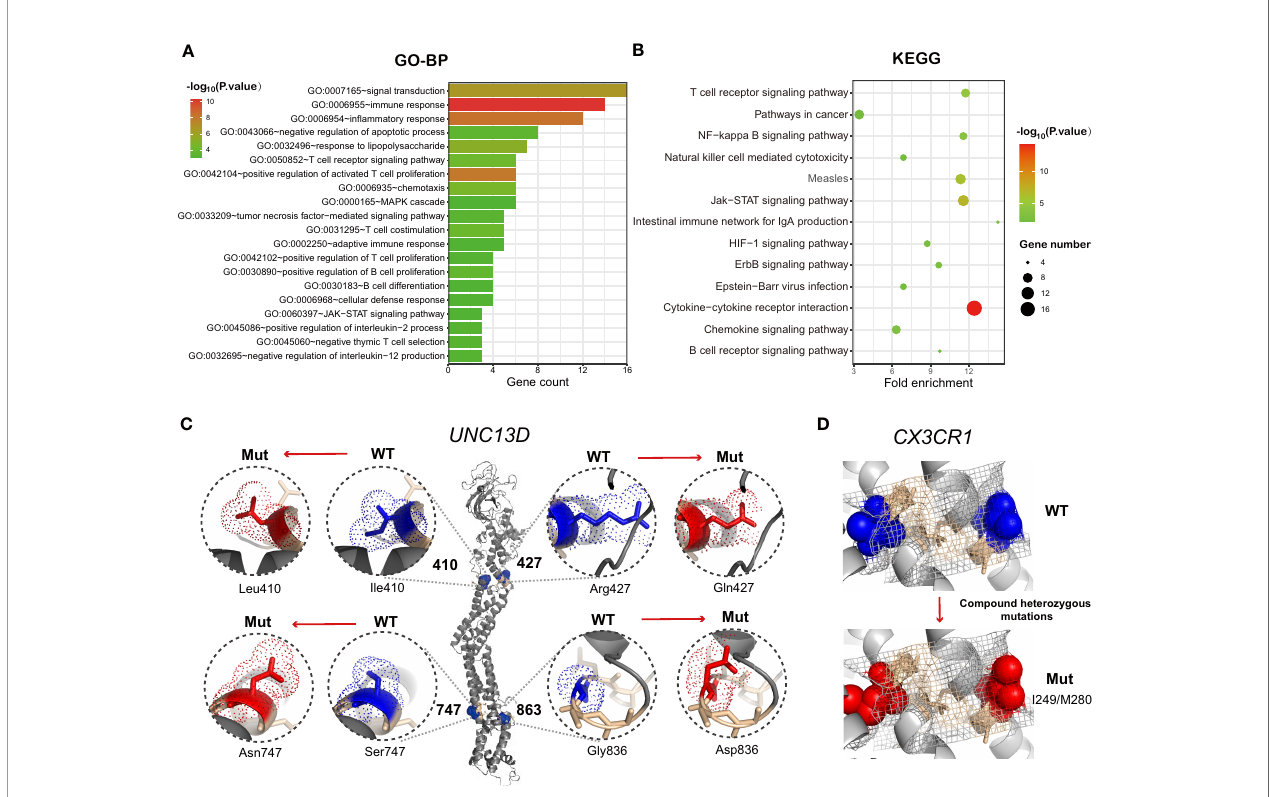
FIGURE 4 | (A) Histograms showing the top 20 GO-BP enrichment results of 47 differentially mutated genes between the T-defect and T-normal groups in Figure 3B . The x-axis represents the enriched gene count, and the intensities of the different colors represent the p values. (B) Bubble diagram showing the top 13 KEGG enrichment items of differentially expressed genes between the patient and two healthy donors. The x-axis represents the gene ratio, and the intensities of the different colors represent the p-values. (C, D) UNC13D mutations and CX3CR1 compound heterozygous mutations were the most frequent germline alterations in the patients. Shown is a ribbon cartoon indicating the locations of WT and mutants in the UNC13D and CX3CR1 proteins. The fi gures were prepared via PyMOL (www.pymol.org). Four UNC13D alterations are reported in ClinVar (rs766652119, rs117221419, rs140184929, rs9904366). Most variants in UNC13D were frameshift and missense variants. The UNC13D p.Arg1077SerfsTer48 variant [NM_199242.3(UNC13D):c.3229_3235del (p.Arg1077fs)] is de fi ned as pathogenic by the American College of Medical Genetics and Genomics (ACMG) and is suspected for for pathogenicity for familial hemophagocytic lymphohistiocytosis (HLH). GO-BP, Gene Ontology-Biological Process; KEGG, Kyoto Encyclopedia of Genes and Genomes; WT, wild type; Mut,